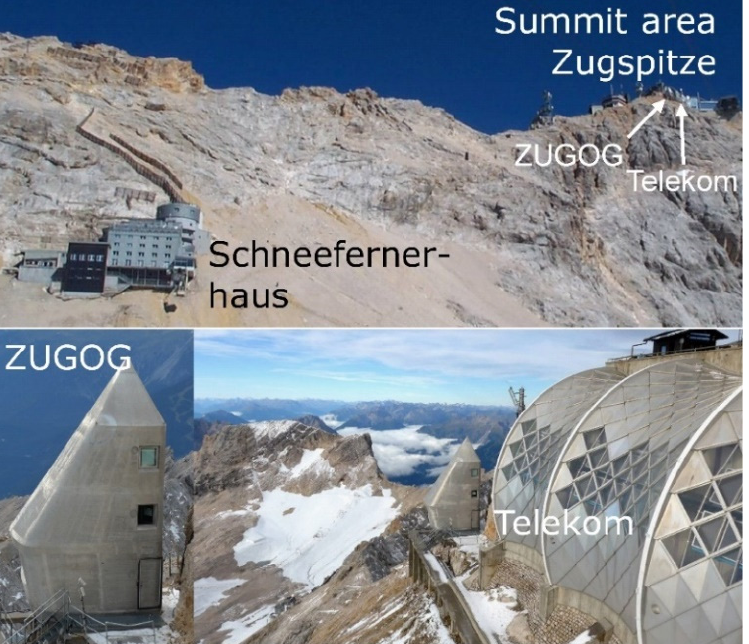
Figure 2. Absolute gravity stations at Mt. Zugspitze. In 2004, first absolute gravity observations were performed in the Telekom building (DFMG Deutsche Funkturm GmbH) in the summit area and in the Environmental Research Station Schneefernerhaus about 300 m below the summit. The Zugspitze Geodynamic Observatory Germany (ZUGOG, GFZ German Research Centre for Geosciences) located next to the Telekom building was established in